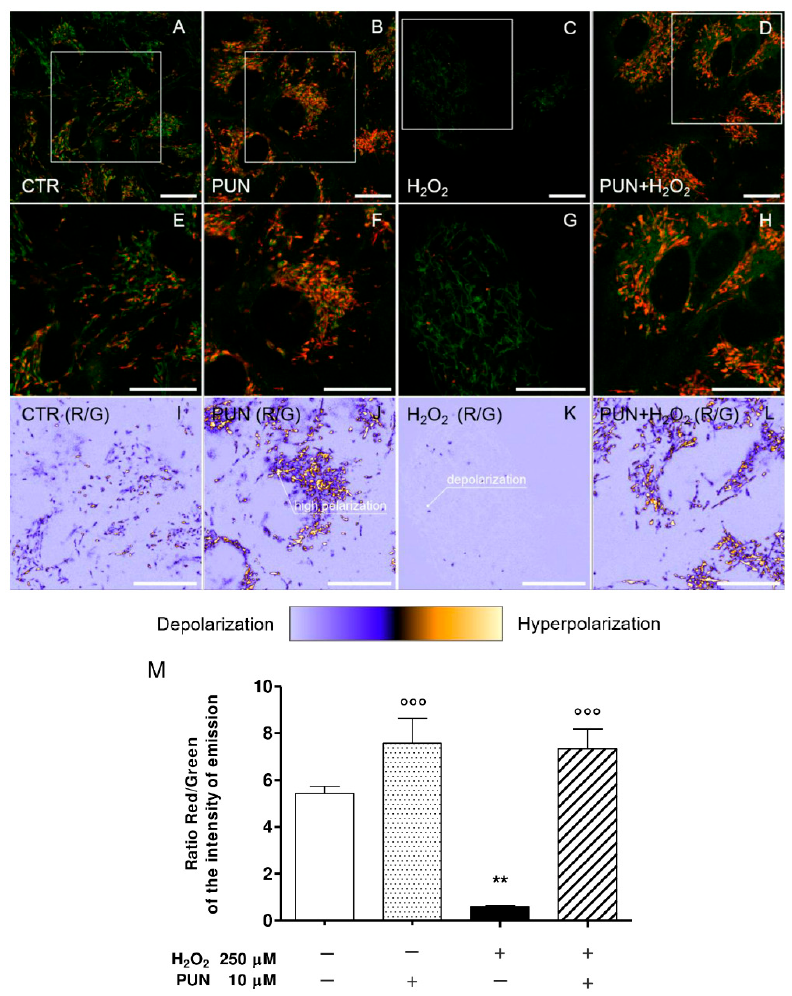
Figure 3. Representative confocal images of ARPE–19 cells untreated (CTR, first column), treated with 10 µ M punicalagin (PUN, second column), treated with 250 µ M hydrogen peroxide (H 2 O 2 , third column), or pre–treated with punicalagin 24 h before H 2 O 2 (PUN+ H 2 O 2 , fourth column). Composite dual–channel images ( A – D ) are shown in the first row, along with a magnification of CTR ( E ), PUN ( F ), H 2 O 2 ( G ), and PUN+ H 2 O 2 ( H ), respectively. The green channel (emission: 525/50 nm) indicates the fluorescence intensity from monomers, while the red channel (emission: 595/50 nm) represents the emissions from aggregates. In the third row, representative maps of the red/green fluorescence intensity ratio (indicated as R/G) are reported for CTR ( I ), PUN ( J ), H 2 O 2 ( K ), and PUN+ H 2 O 2 ( L ), respectively. Each pixel’s color spans from light purple (low R/G emission intensity ratio, mitochondrial depolarization) to yellow (high R/G emission intensity ratio, mitochondrial hyper- polarization). Values of the emission intensity ratio range from 0 to 15. The means ± 1 SEM of the ratio are summarized in the bar plot reported in ( M ). Results are from two independent experiments, each including three replicates per experimental group. One–way ANOVA analysis was carried out followed by post hoc Newman–Keuls test. ** = p < 0.01 vs. control; ◦◦◦ = p < 0.001 vs. 250 µ M H 2 O 2